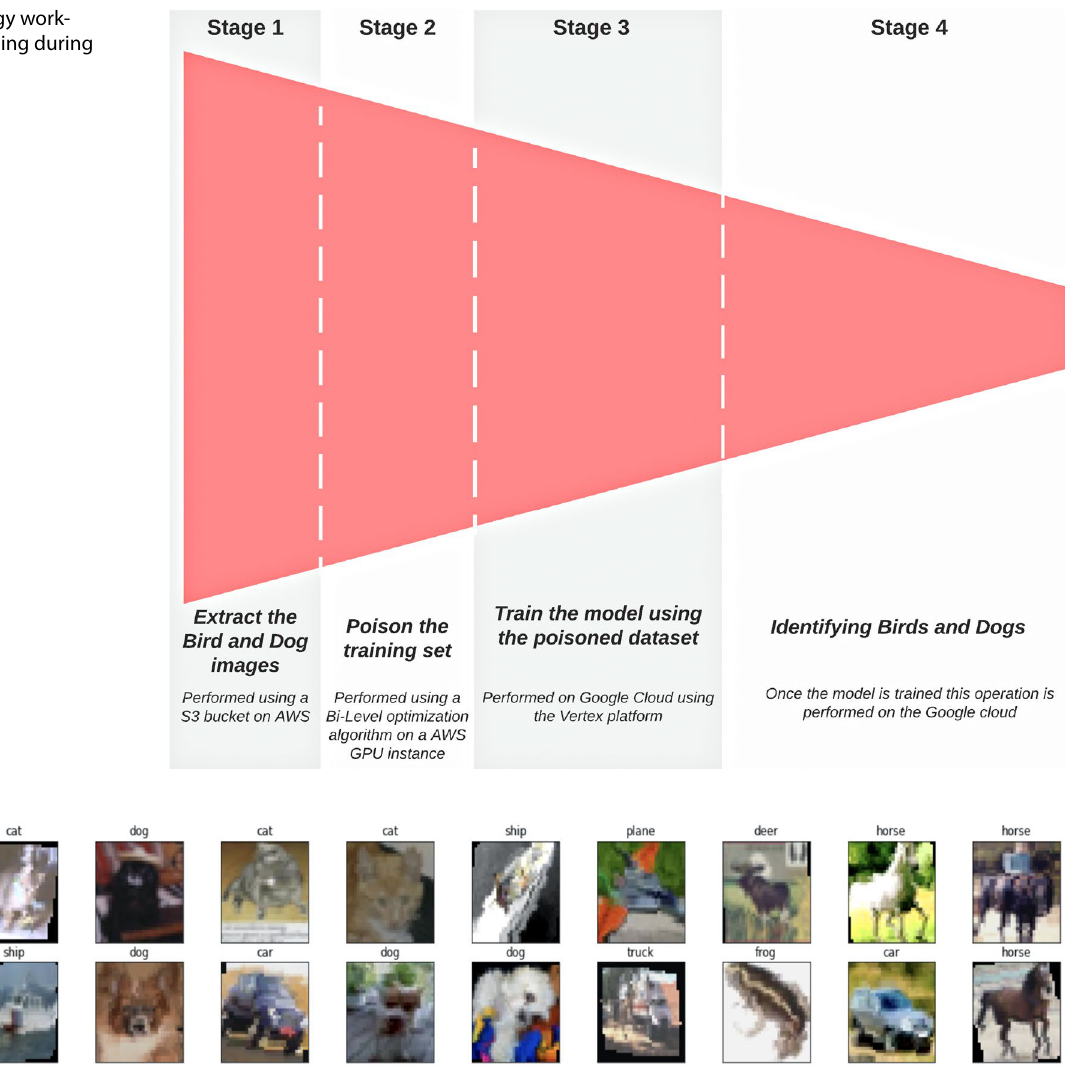
Fig. 3 CIFAR-10 Dataset sample